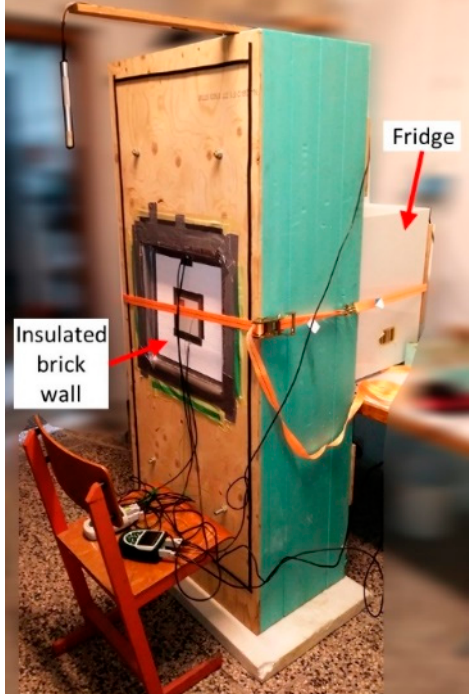
Figure 2. Test setup with prepared insulated brick wall specimen in the opening of the specially